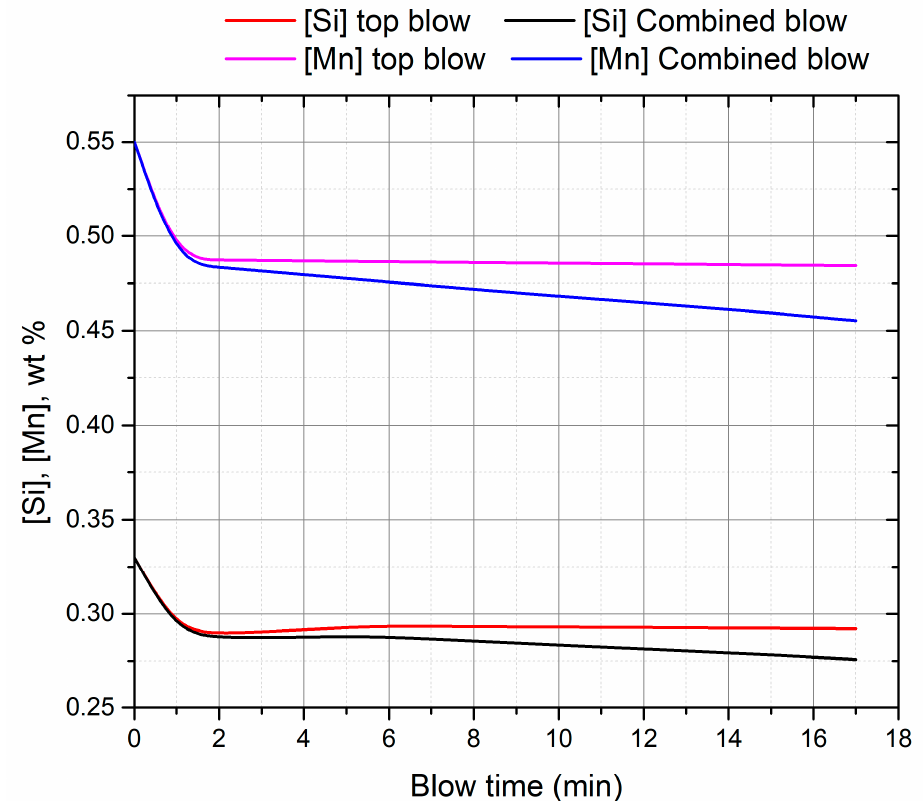
Figure 9. Effect of top and combined blows on the silicon and manganese oxidation rates during oxygen blow.